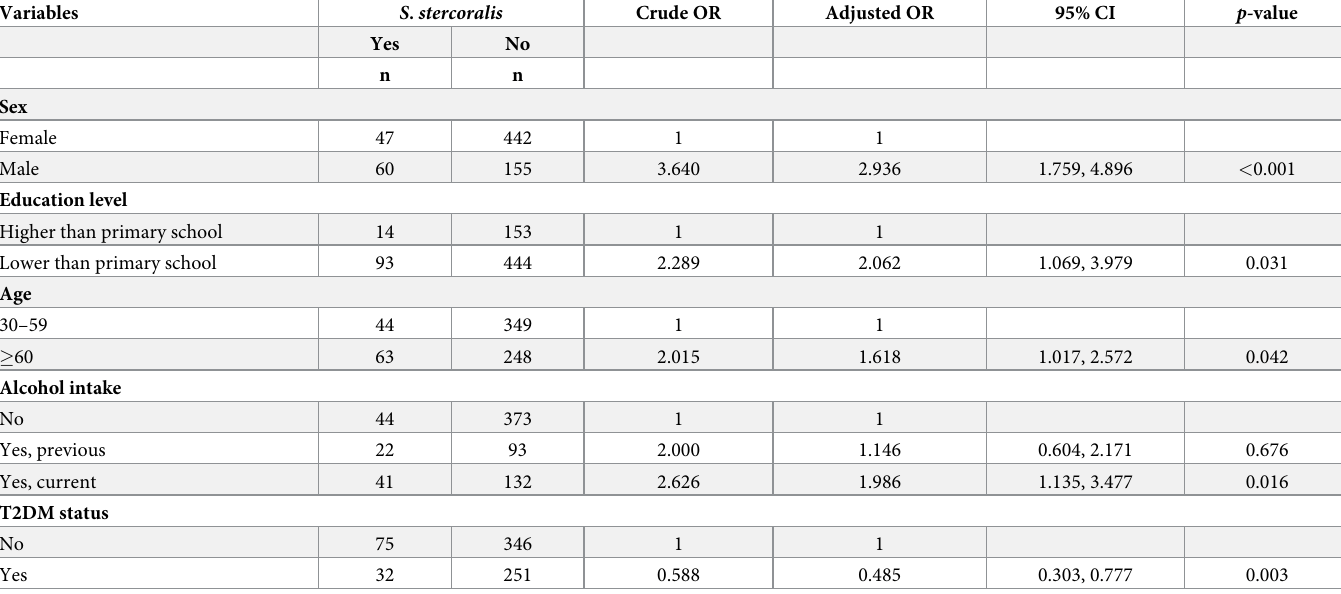
Table 3. Multivariable logistic regression analyses of factors associated with S . stercoralis infection ( n = 704). Variables